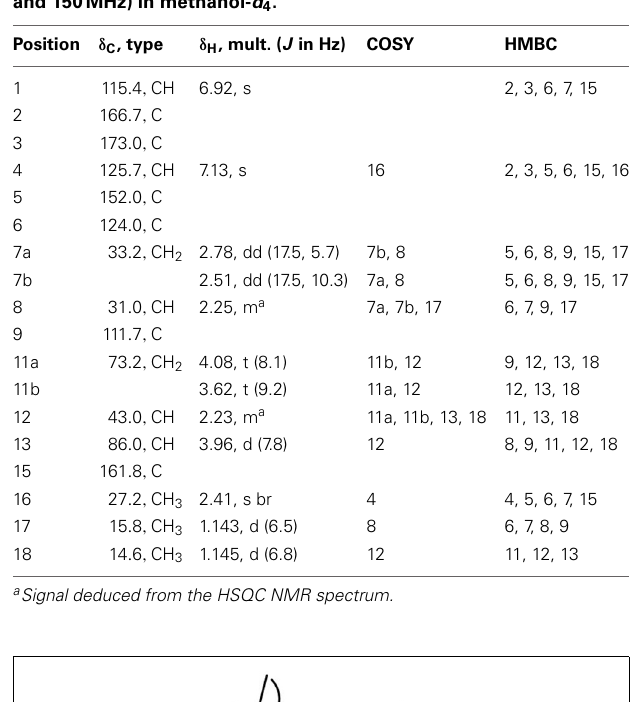
Table 4 | IC 50 values for antibacterial and antifungal activities